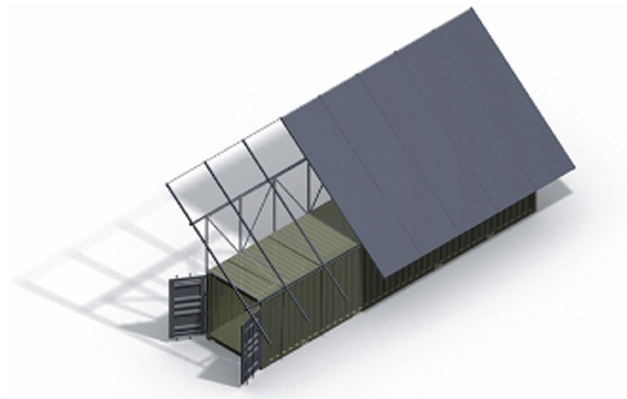
Figure 2. Wattpic FSA Container (model without solar